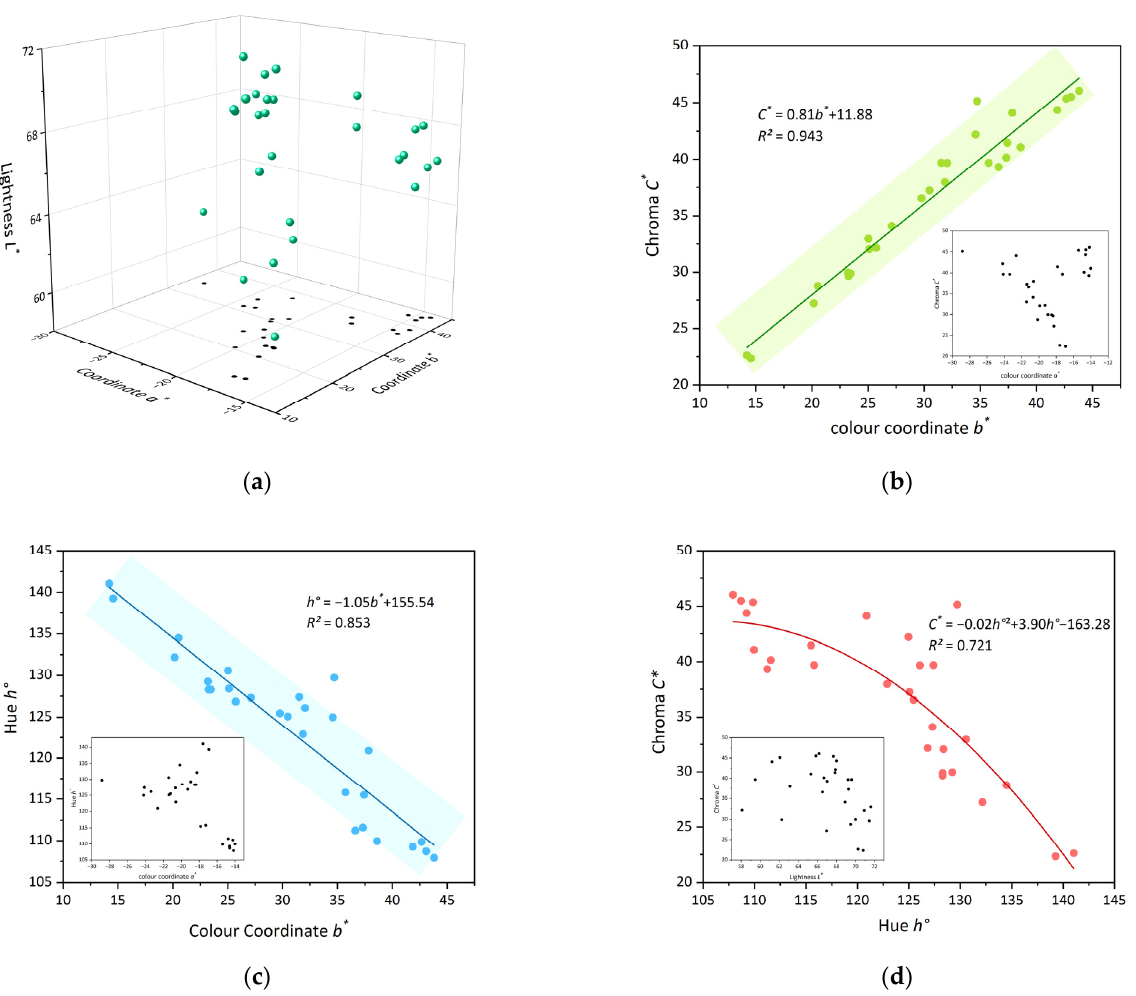
Figure 2. ( a ) The distribution of sample parameters in CIE 1976 L*a*b* uniform color space; ( b ) Chroma C* is highly positively correlated with color coordinate b* ; ( c ) Hue h° is highly negatively correlated with color coordinate b* ; ( d ) Chroma C* is highly negatively correlated with hue h° .